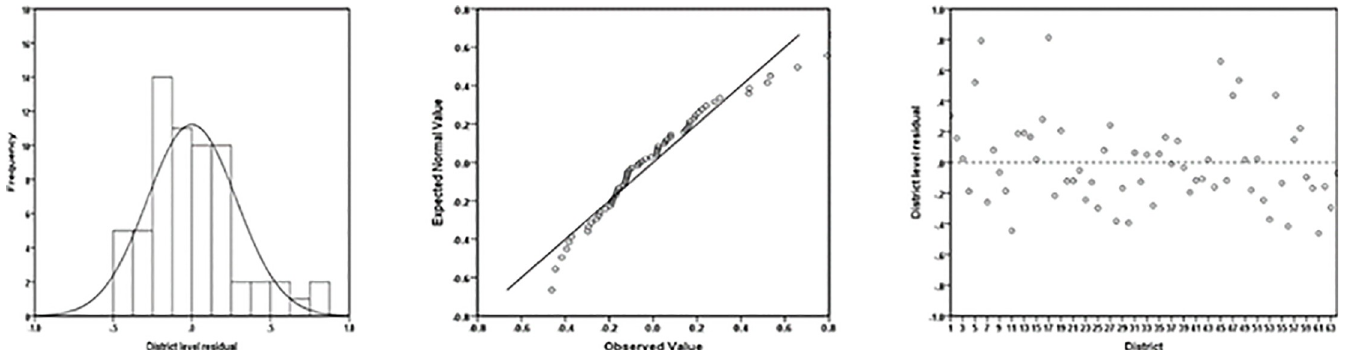
Fig 5. Histograms (left plot), normal q-q plots (centre plot) and distributions of the district-level residuals (right plot).